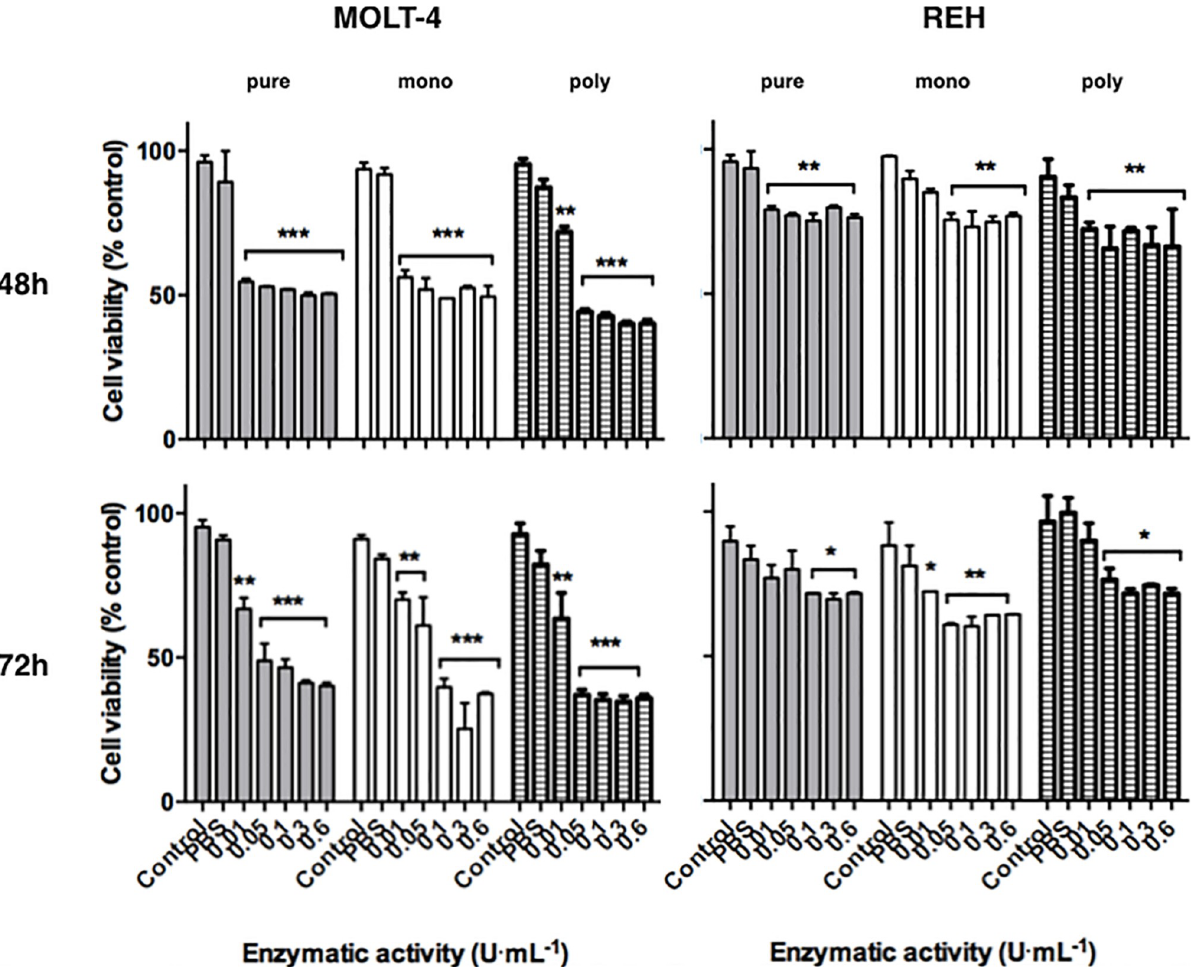
Fig 6. Cytotoxicity of monoPEG-ASNase in MOLT-4 and REH cells. Assays performed at 48 h and 72 h, with cells alone (control), without enzyme (PBS) and at different concentrations of enzymatic activity (0.01, 0.05, 0.1, 0.3 or 0.6 U.mL -1 ). Grey bars—free ASNase and white bars— monoPEGylated ASNase. Error bars represent the standard deviation. Likelihood of significance less than 0.05 ( � ), less than 0.01 ( �� ) and less than 0.001 ( ��� ) when compared with the control.